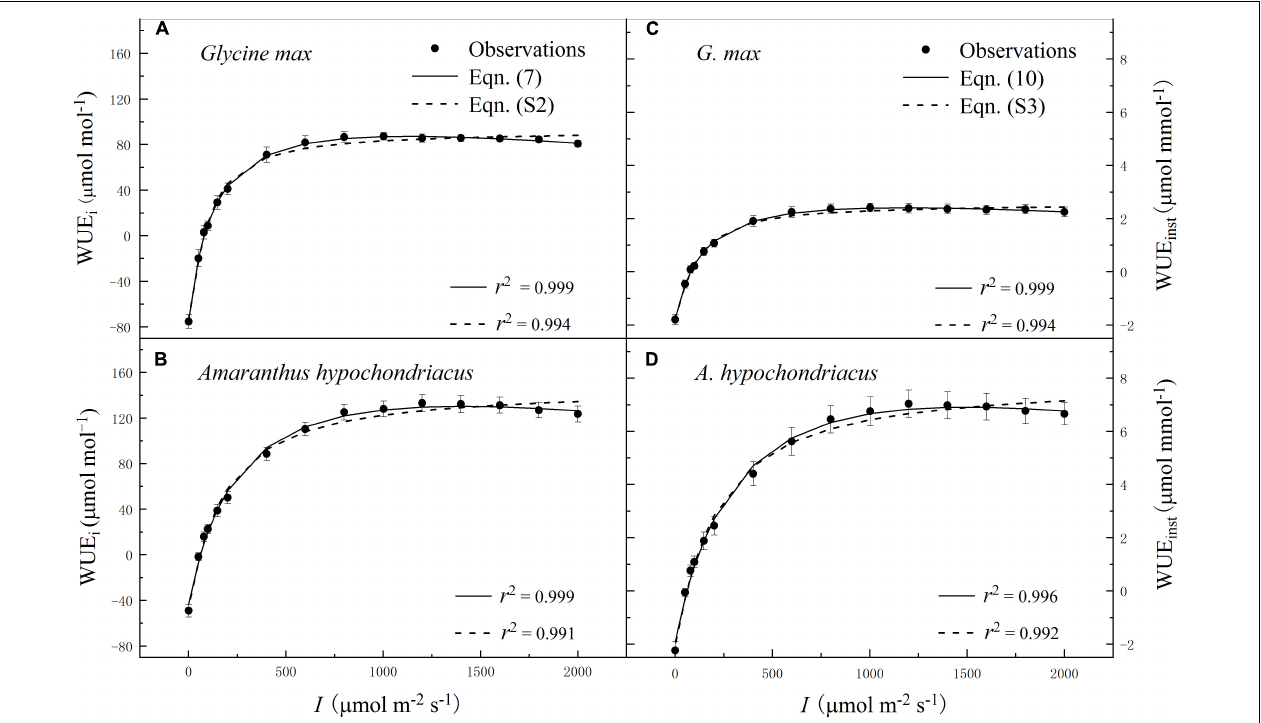
FIGURE 2 | Irradiance ( I ) response of intrinsic water-use efficiency (WUE i ) (A,B) and instantaneous water-use efficiency (WUE inst ) (C,D) for C 3 [soybean ( Glycine max )] and C 4 species [grain amaranth ( Amaranthus hypochondriacus )], respectively. In plots (A) and (B) , solid lines were fitted using Eq. 7 and dashed lines were fitted using the non-rectangular hyperbola model (Eq. S2). In plots (C) and (D) , solid lines were fitted using Eq. 10 and dashed lines were fitted using the non-rectangular hyperbola model (Eq. S3). Data are the mean ± SE ( n =